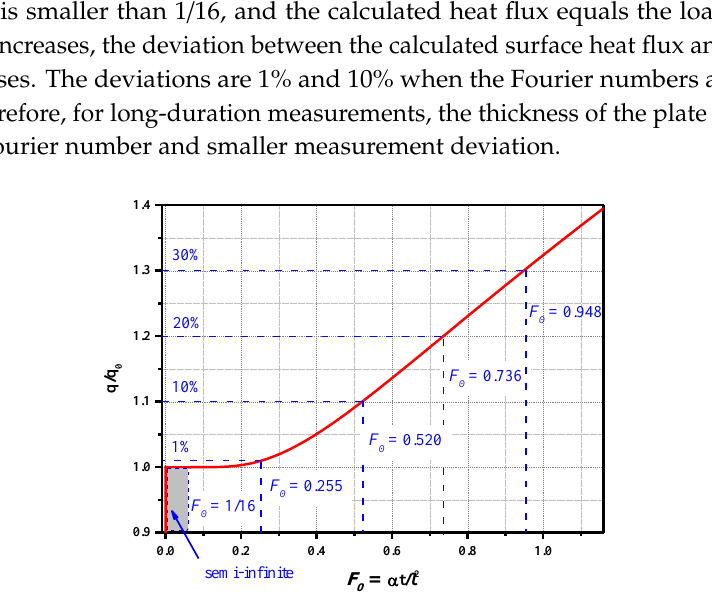
Figure 2. Calculated heat flux versus the Fourier number for 1D heat conduction.